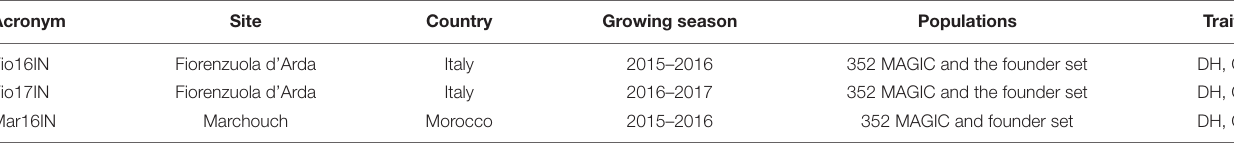
TABLE 2 | Field trials carried out for phenotyping the whole MAGIC population and the founder set for GY. Acronym Site Country Growing season Populations